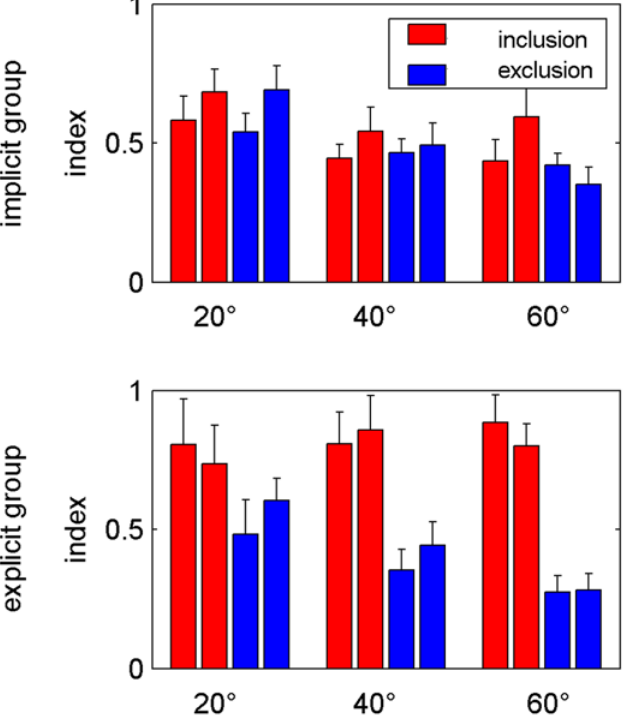
Fig 4. Inclusion and exclusion. Mean inclusion (red) and exclusion (blue) indices for all three perturbation sizes (20°, 40° and 60°) separately for the implicit (A) and explicit (B) group. Error bars indicate standard errors. For the inclusion index statistical analysis yielded a significant effect of Group (p < 0.05), but no effects of Rotation Size, Block Order or any interaction (all p > 0.05). For the exclusion index the analysis revealed a significant effect of Rotation Size (p < 0.001). No significant effects of Group, Block Order or any interaction was found here (all p >